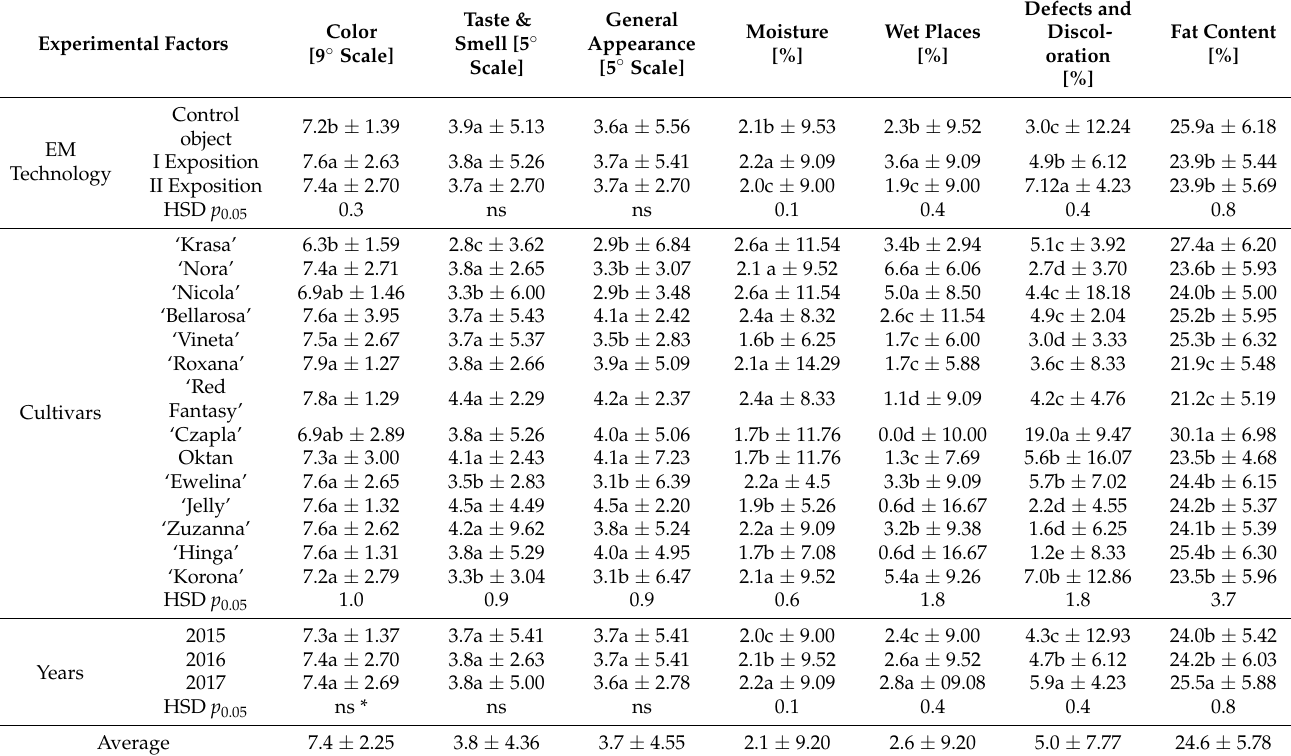
Table 3. The quality assessment of PC and their variability (RSD in